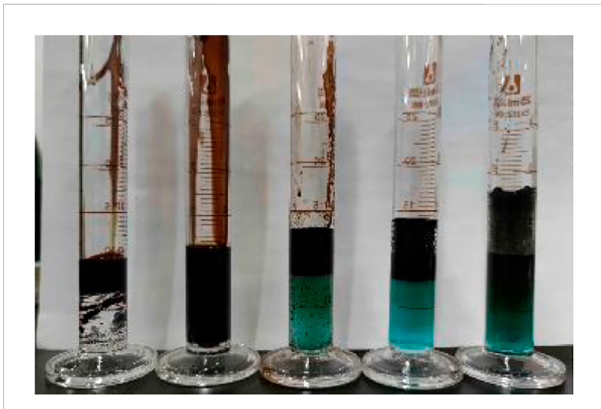
FIGURE 12 Produced fl uid status in nitrogen foam fl ooding